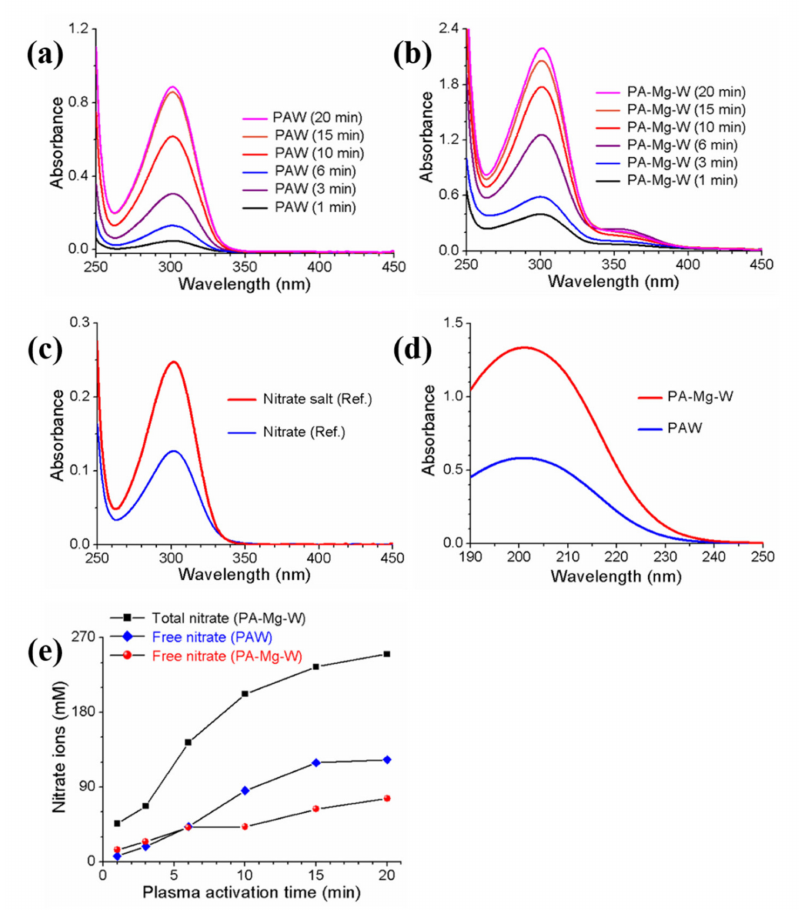
Figure 5. UV-visible absorption spectra of the ( a ) PAW and ( b ) PA-Mg-W over a wavelength range of 250–450 nm. ( c ) Absorption spectra of the reference free nitrate and nitrate salt (Mg ( NO 3 ) solutions. ( d ) Absorption spectra of the PAW and PA-Mg-W over a wavelength range of 190–250 nm. ( e ) Nitrate ion concentrations in the PAW and